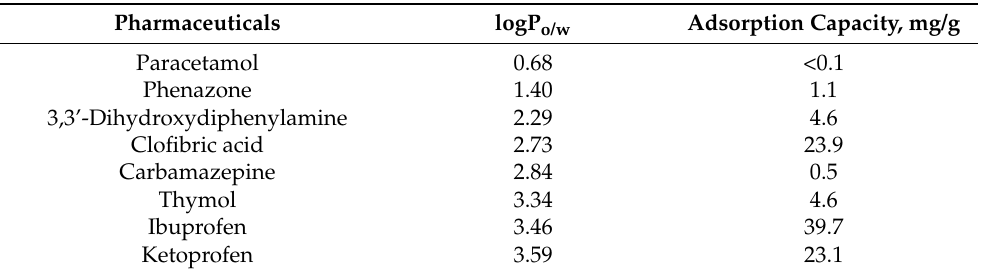
Table 2. 1-Octanol/water solvent partitioning coefficients (logP o/w ) and adsorption capacities of DNA–CS hydrogels for